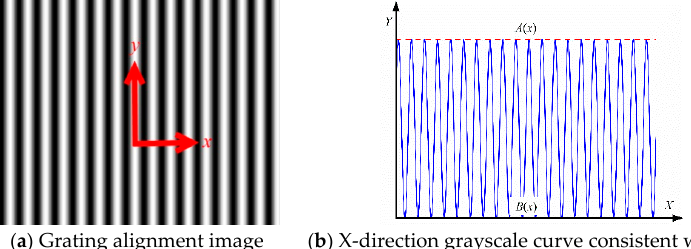
Figure 4 . Non -Rotation Mask. Figure 4. Non-Rotation